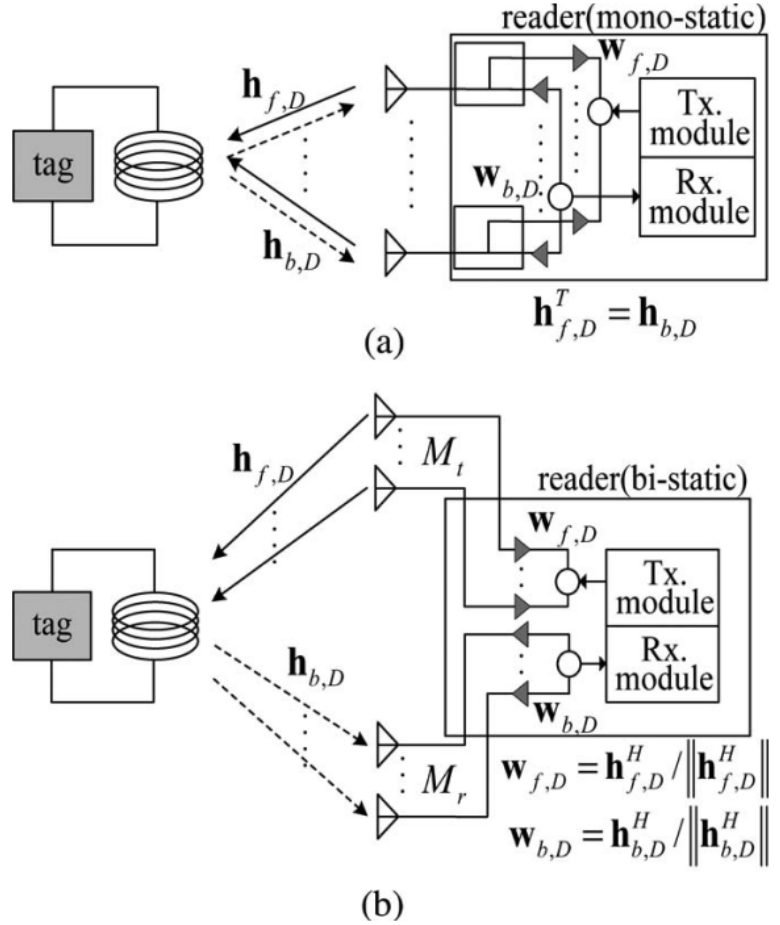
Figure 2. ( a ) Mono-static RFID Reader ( b ) Bi-static RFID Reader. Reproduced from [24] with permission from IEEE.